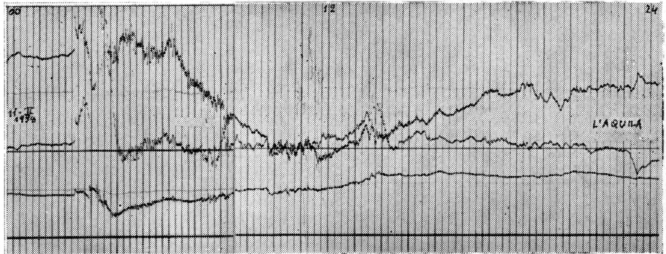
Fig. 2. Magnetic storm recorded on 11 February, 1958 at L’Aquila reporting the three traces of horizontal component, declination and vertical component time variations (from: Istituto Nazionale di Geofisica,